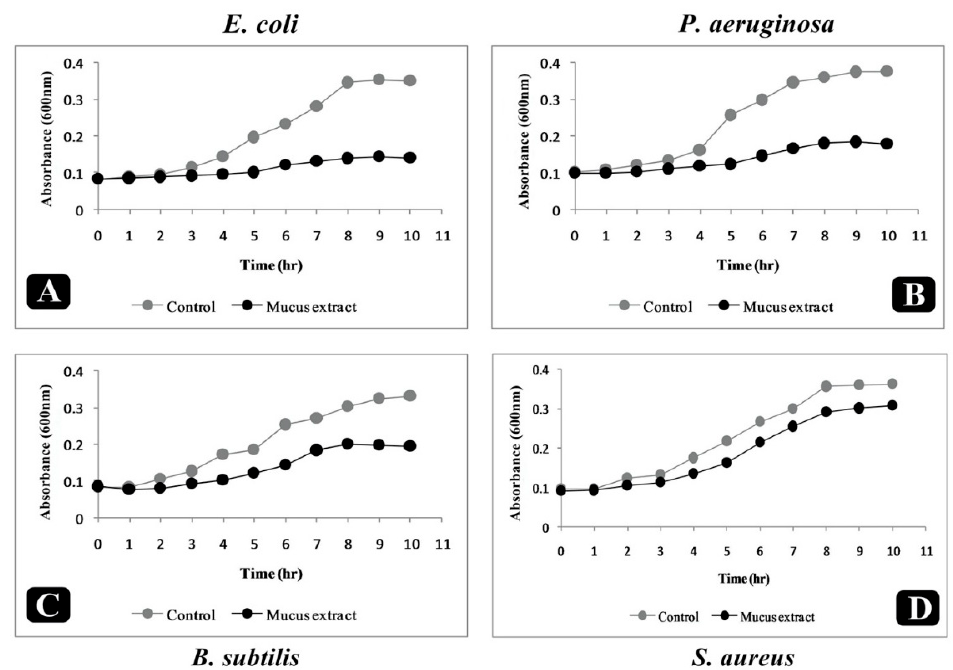
Figure 3. Growth kinetics analysis of bacteria. ( A ) Growth kinetics of E. coli , with and without mucus extract, ( B ) growth kinetics of P. aeruginosa , with and without mucus extract, ( C ) growth kinetics of B. subtilis , with and without mucus extract, and ( D ) growth kinetics of S. aureus , with and without mucus extract.